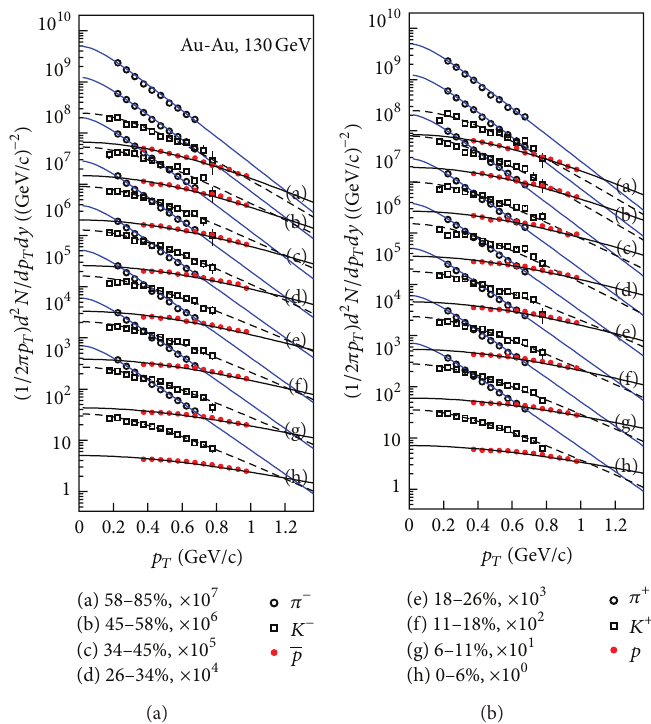
Figure 6: The same as Figure 5, but showing the results at √𝑠 𝑁𝑁 = 130 GeV.